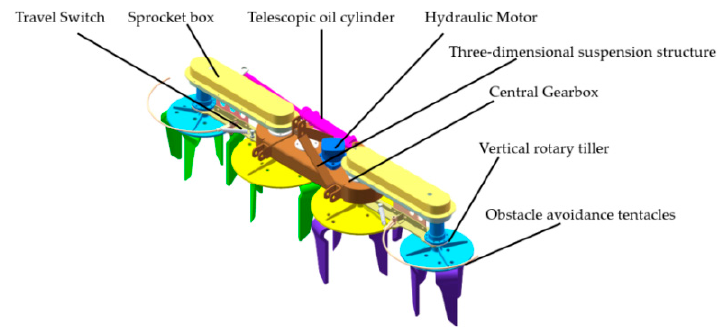
Figure 1. Vertical rotary tiller structure diagram.